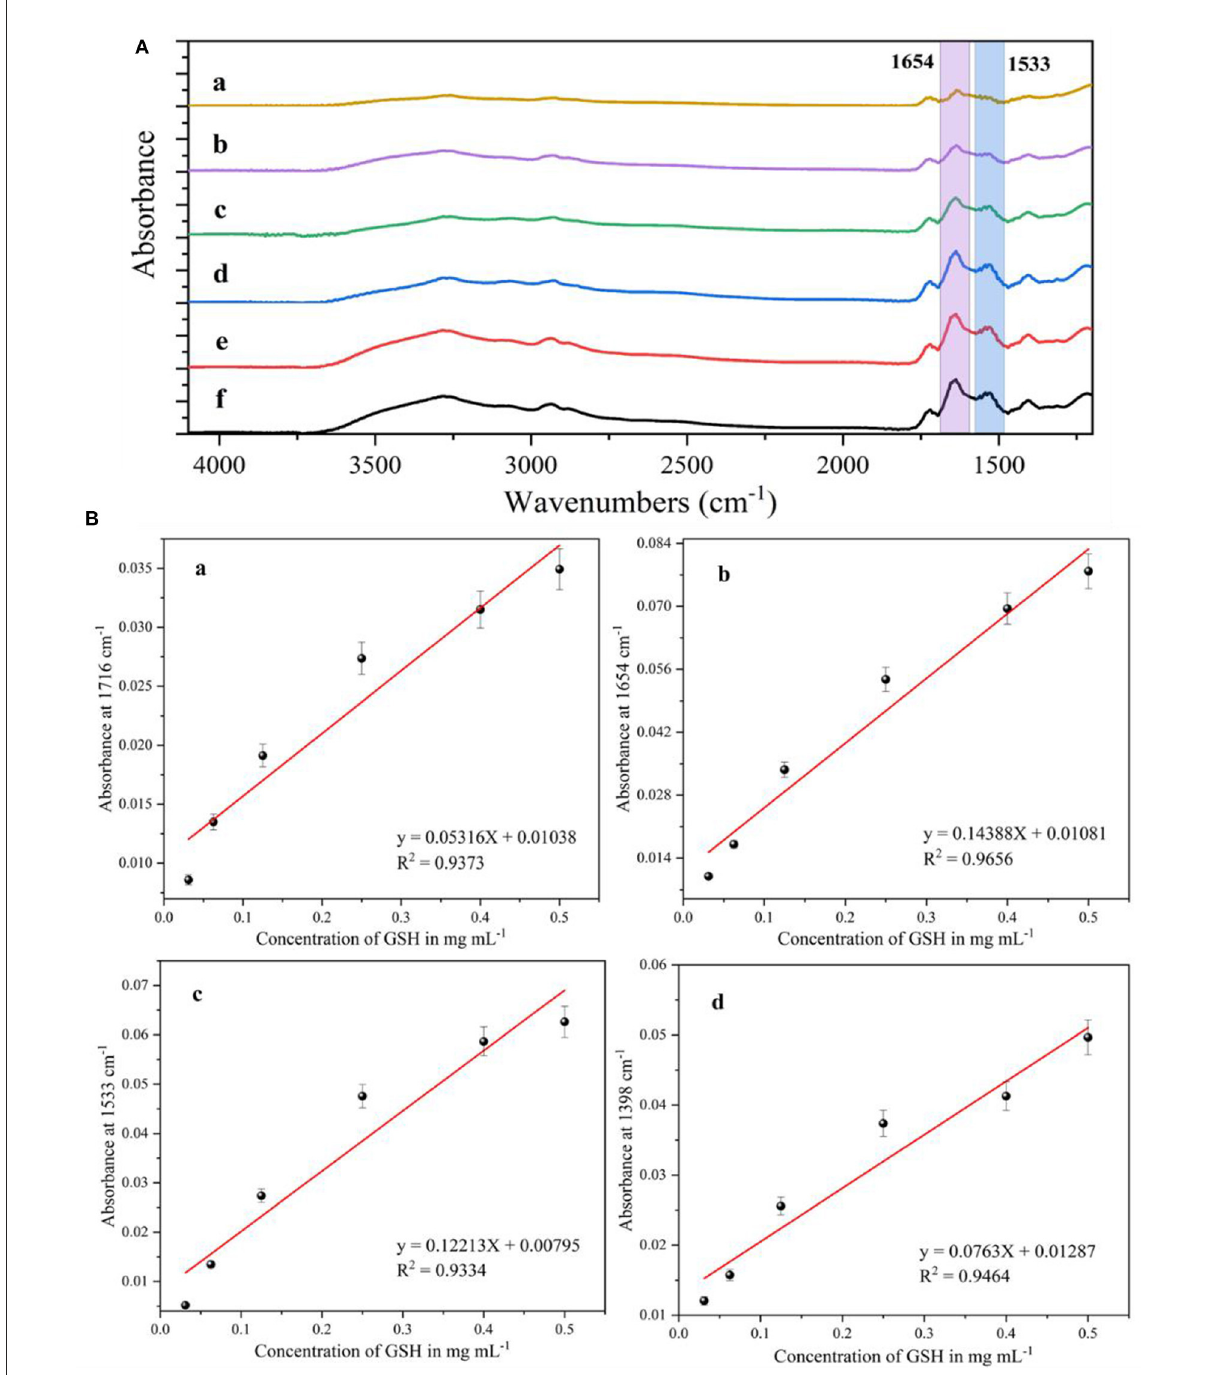
FIGURE5 (A) Surface-enhanced infrared absorption spectra of glutathione at different concentrations, (a) 0.03 mg/mL; (b) 0.06 mg/mL; (c) 0.12 mg/mL; (d) 0.25 mg/mL; (e) 0.4 mg/mL; (f) 0.5 mg/mL. (B) Fitting curves of infrared characteristic absorption peak intensities to glutathione concentrations at different wave numbers, (a) 1,716 cm − 1 ; (b) 1,654 cm − 1 ; (c) 1,533 cm − 1 ; (d) 1,398 cm − 1 .